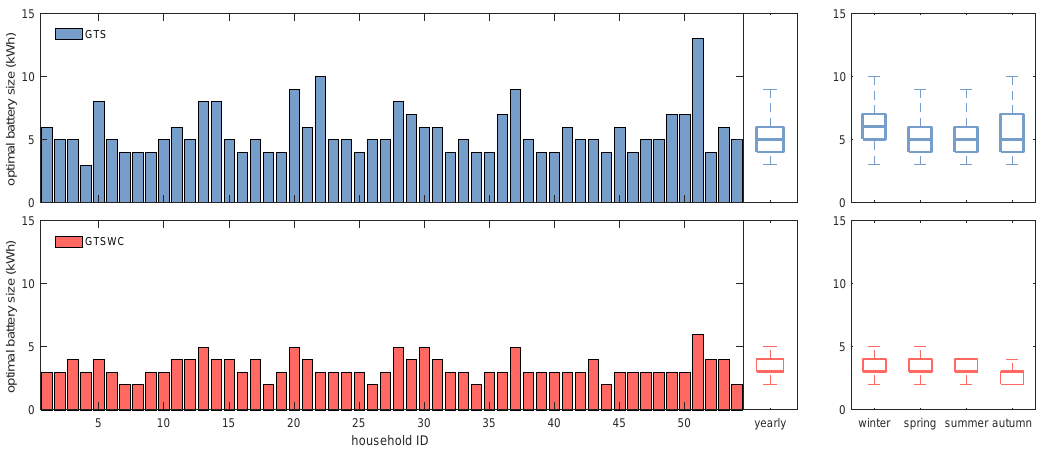
Figure 2. Optimal battery sizes. The results are obtained through a process as described in [9]. Battery capacities between 1 and 27 kWh were analysed. The optimal battery sizes for the individual households from simulation runs over the period of an entire year are reported. Furthermore, statistical results for these simulations, as well as independent seasonal simulations are